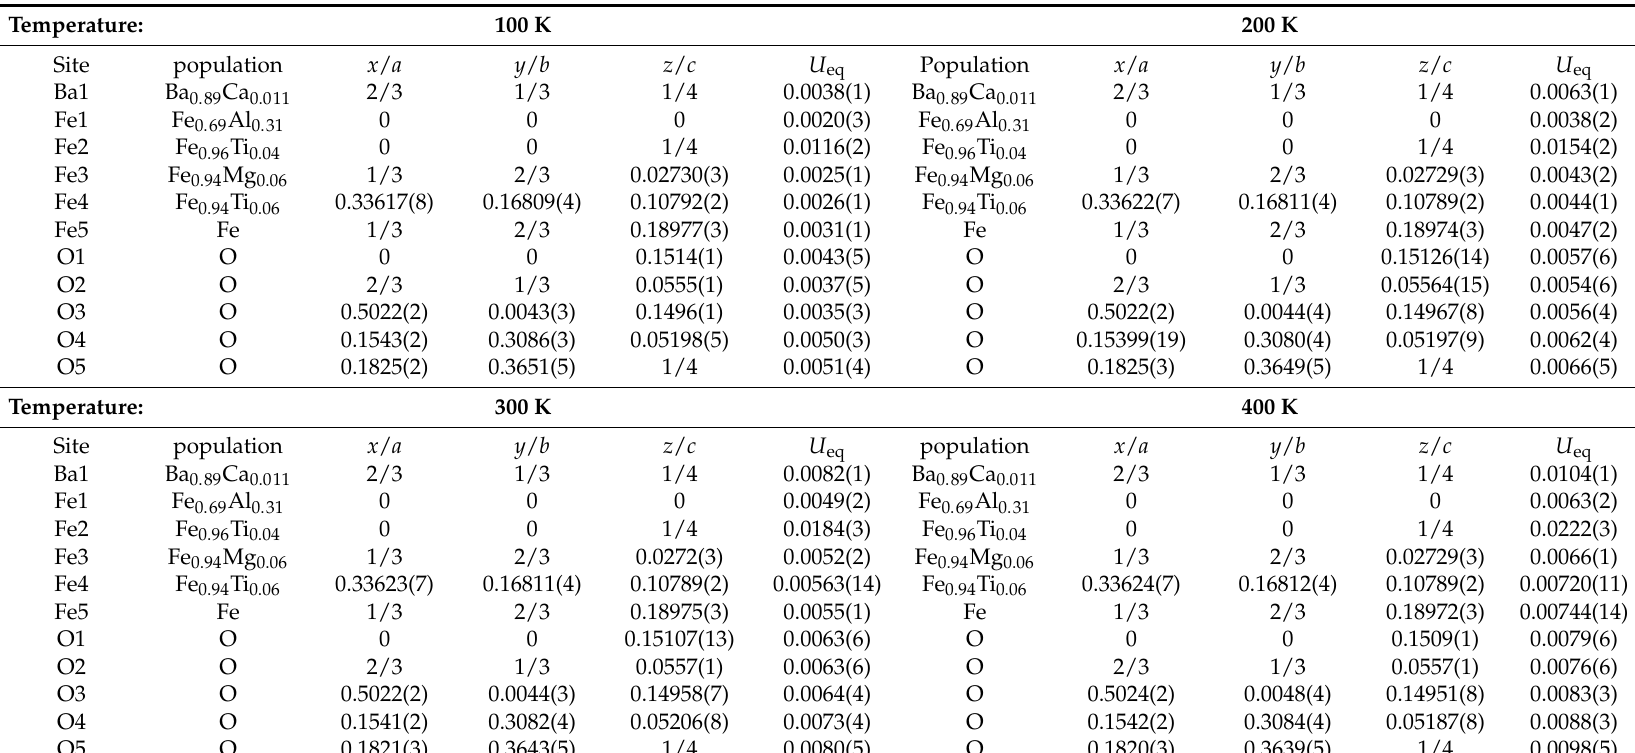
Table 3. Atomic coordinates, displacement parameters (Å 2 ), and site occupancies for barioferrite at 100, 200, 300, and 400